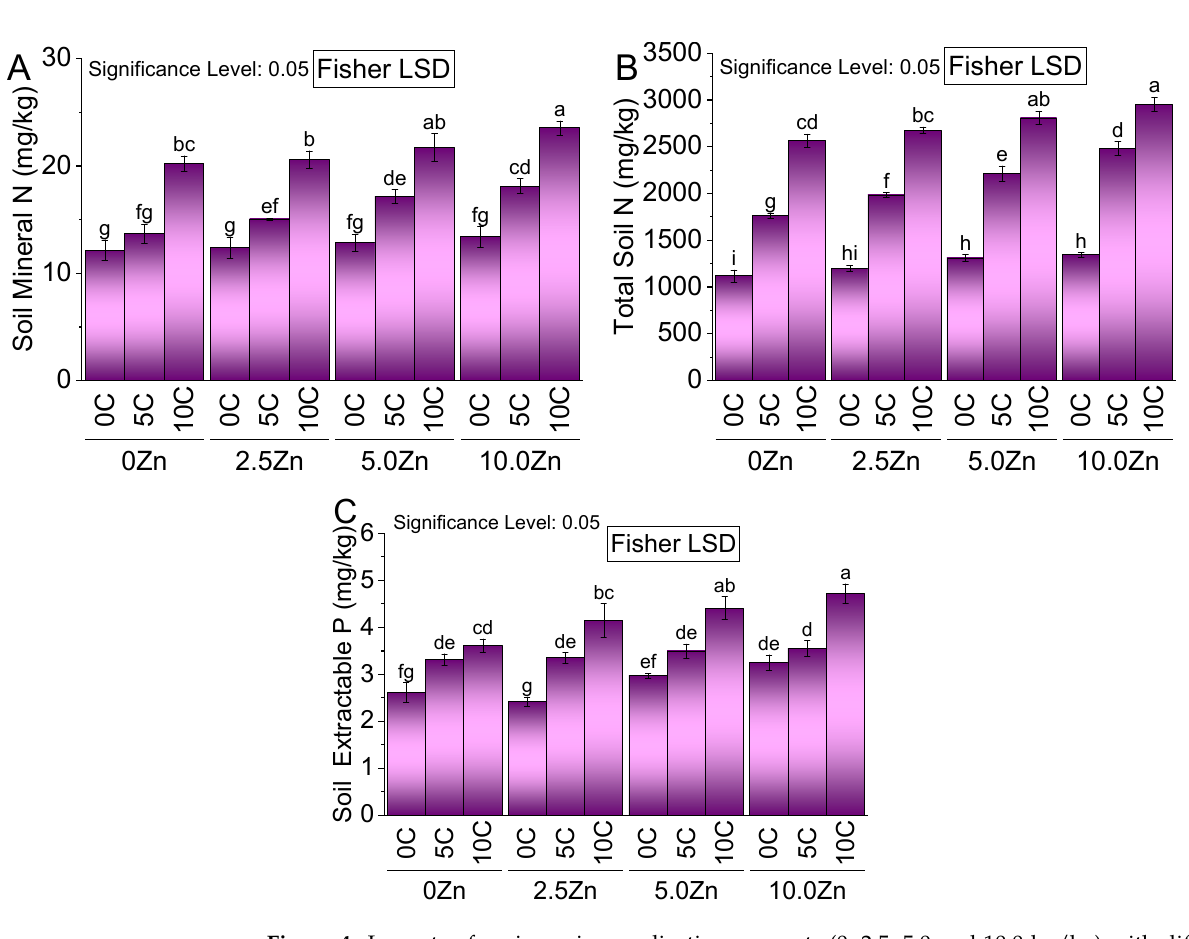
Figure 4. Impacts of various zinc application amounts (0, 2.5, 5.0 and 10.0 kg/ha) with different levels of compost (0, 5 and 10 t/ha) on soil mineral nitrogen ( A ), total soil nitrogen ( B ) and total soil extractable P ( C ) of wheat. Different letters above bars represent significant changes at p ≤ 0.05 using Fisher’s LSD test.